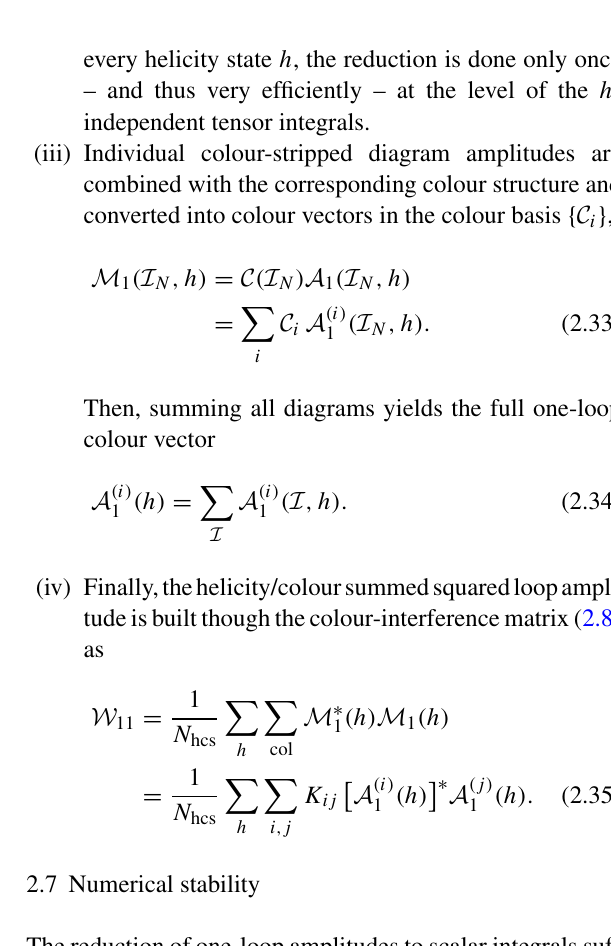
Steps (i)—(iii) are iterated until the loop is entirely dressed.